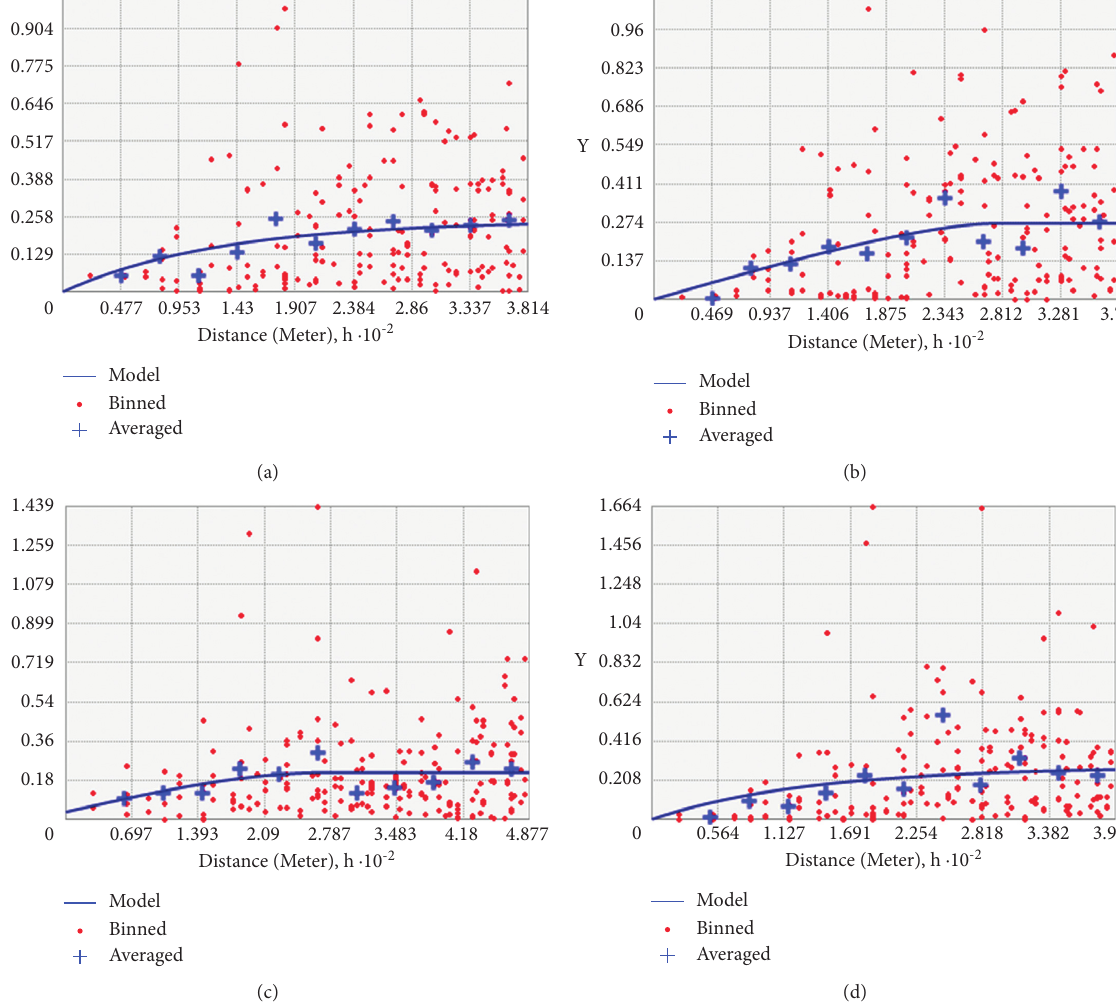
Figure 3: Semivariograms of SOC and SOCS at two depths with the lines indicating best-fit model. (a) SOC (g/kg) 0–20cm. (b) SOC (g/kg) 20–40cm. (c) SOCS (kg/m 2 ) 0–20cm. (d) SOCS (kg/m 2 ) 20–40 cm.